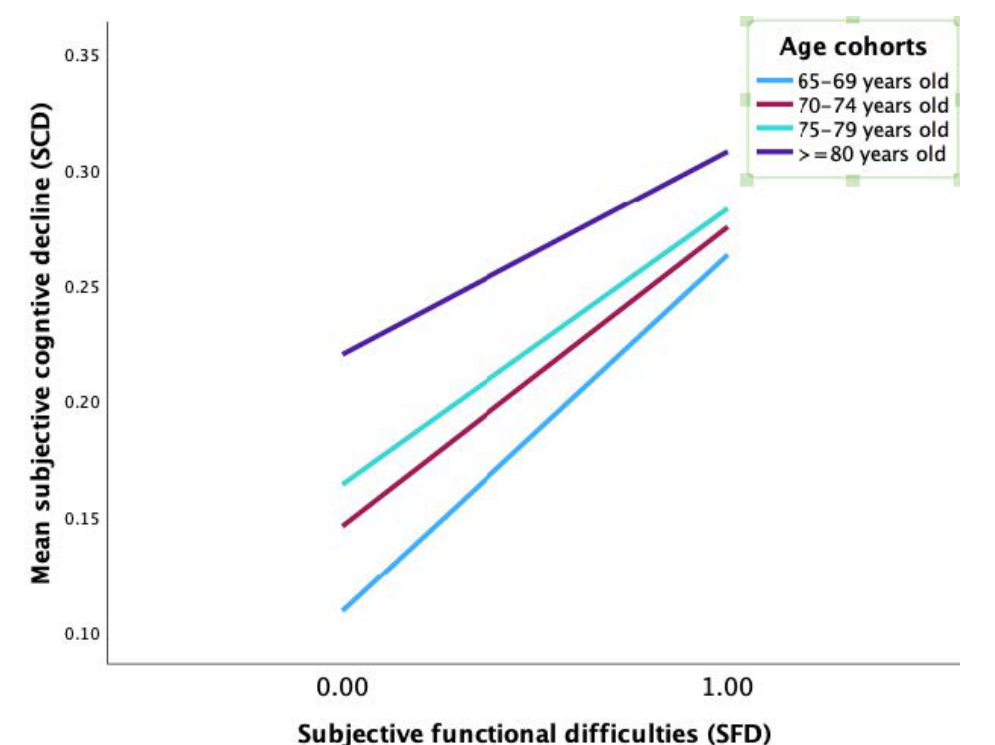
Figure 3. Simple slope analysis showed that the predictive effect of mentally unhealthy days on the SCD was not statistically significant at each level of the age cohorts.